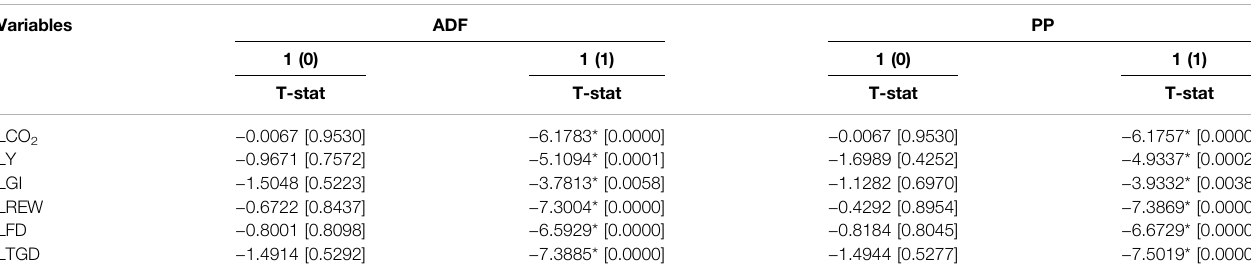
TABLE 2 | PP and ADF